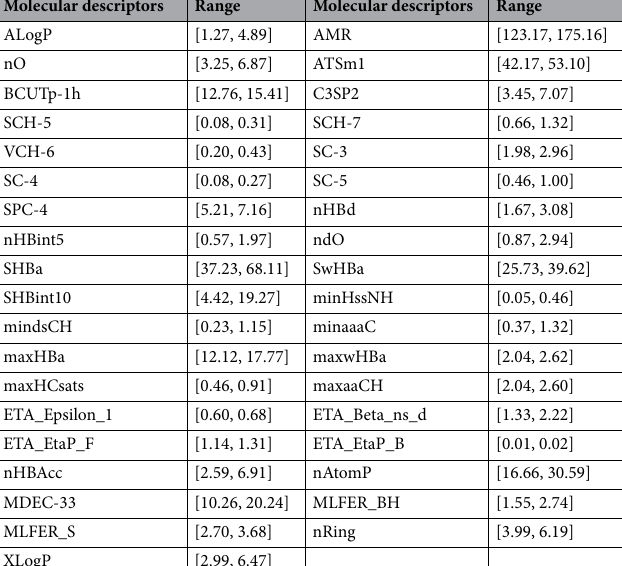
Table 5. Molecular descriptor value range.